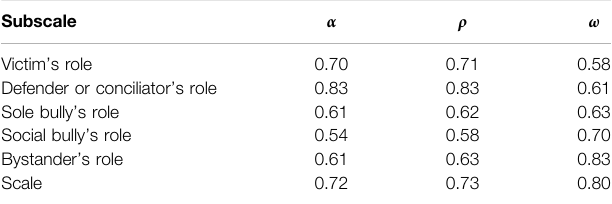
TABLE 3 | Scale and subscale internal consistency values of the ERECVE. Subscale